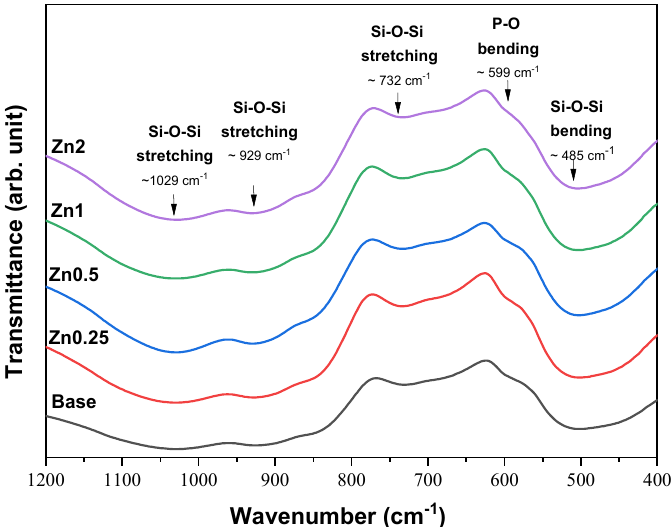
Figure 2. FTIR results of the base Bioglass ® and the bioactive glasses with several concentrations of zinc (0.25, 0.5, 1 and 2 wt%).